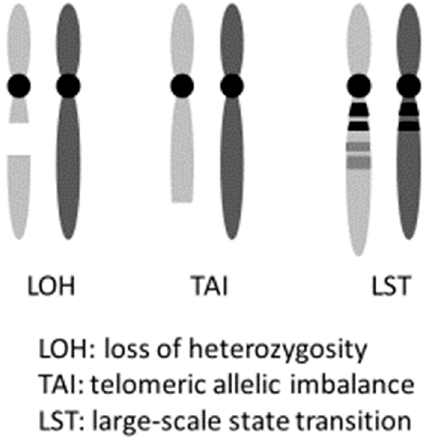
Figure 2. myChoice HRD score (Genomic instability status).